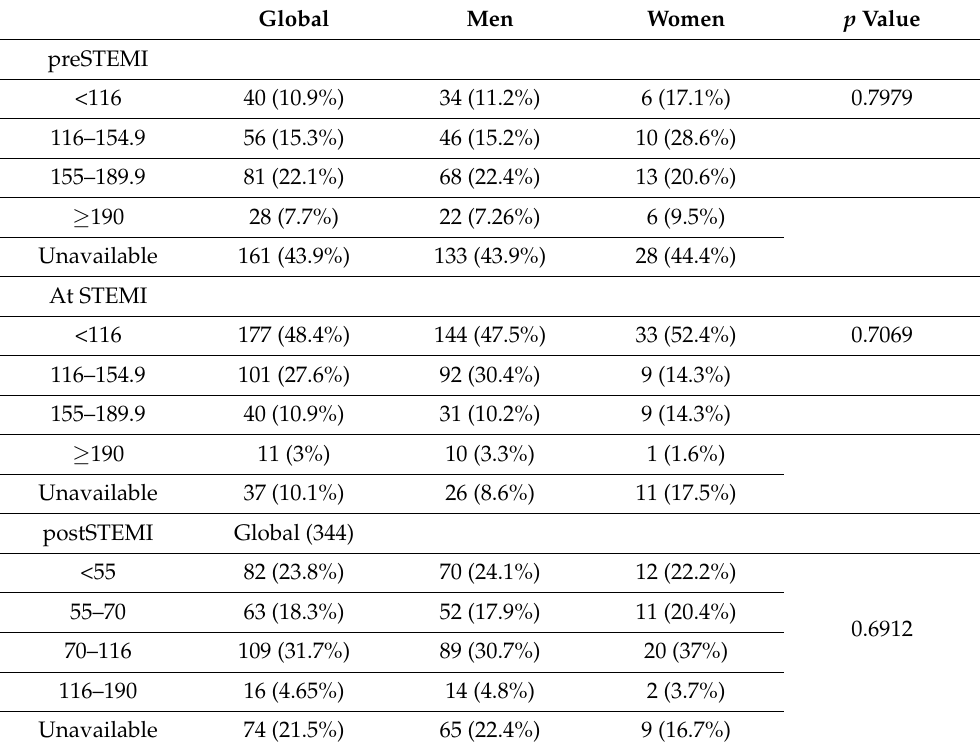
Table 2. LDLc levels prior to STEMI, during STEMI admission, and control LDL levels after STEMI.